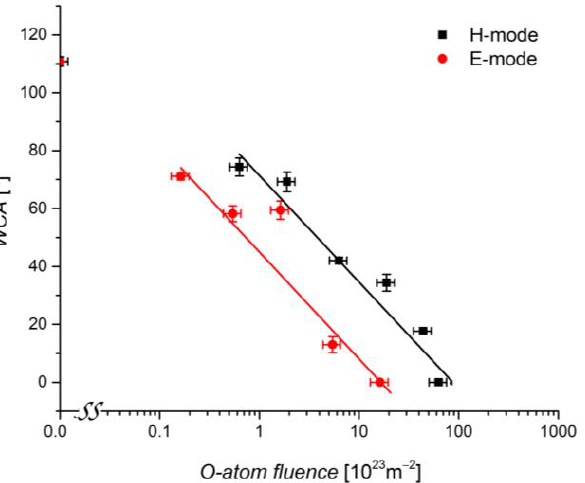
Figure 7. Water contact angle (WCA) on the wheat seed surface versus the fluence of O-atoms in E-mode or H-mode plasma at various treatment times. The error bars represent standard error. Mean values (±SE) for the respective triplicates of WCA are given.